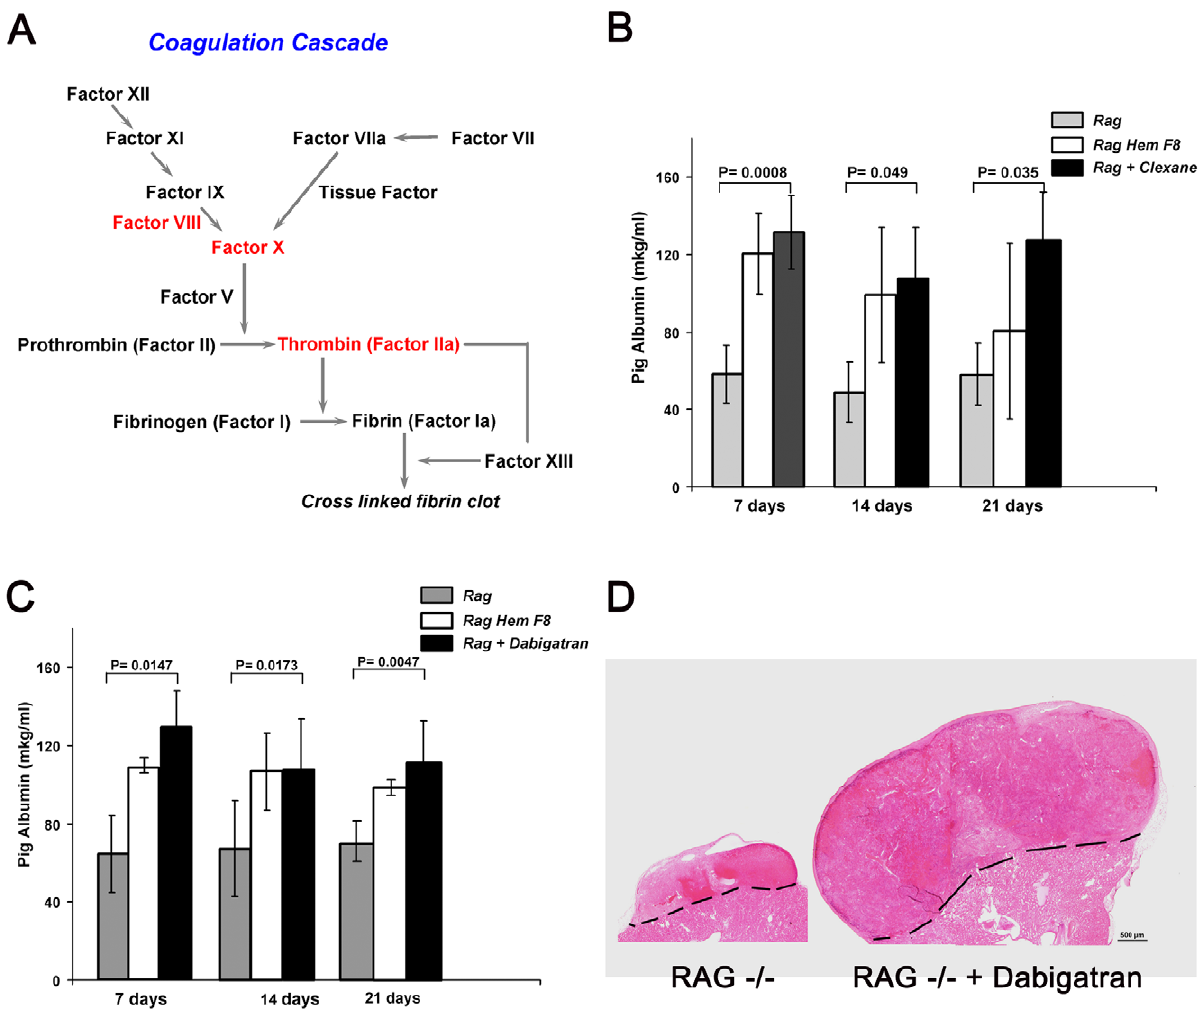
Figure 5. Direct involvement of coagulation cascade factors in enhancement of growth of pig embryonic transplants. A. Coagulation cascade scheme. B. Enhancement of embryonic pig liver growth by Clexane administration in Rag 2 / 2 mice C. Enhancement of embryonic pig liver growth by Dabigatran administration in Rag 2 / 2 mice. Pig albumin serum levels, detected by specific ELISA, are shown at 7, 14 and 21 days after implantation of E42 pig liver precursor tissue in the presence or absence of Dabigatran administration. The results are compared to those obtained in hemophilic Rag 2 / 2 factor VIII KO mice. D. E42 pig spleen transplant with and without Dabigatran administration in hemophilic Rag 2 / 2 factor VIII KO mice.